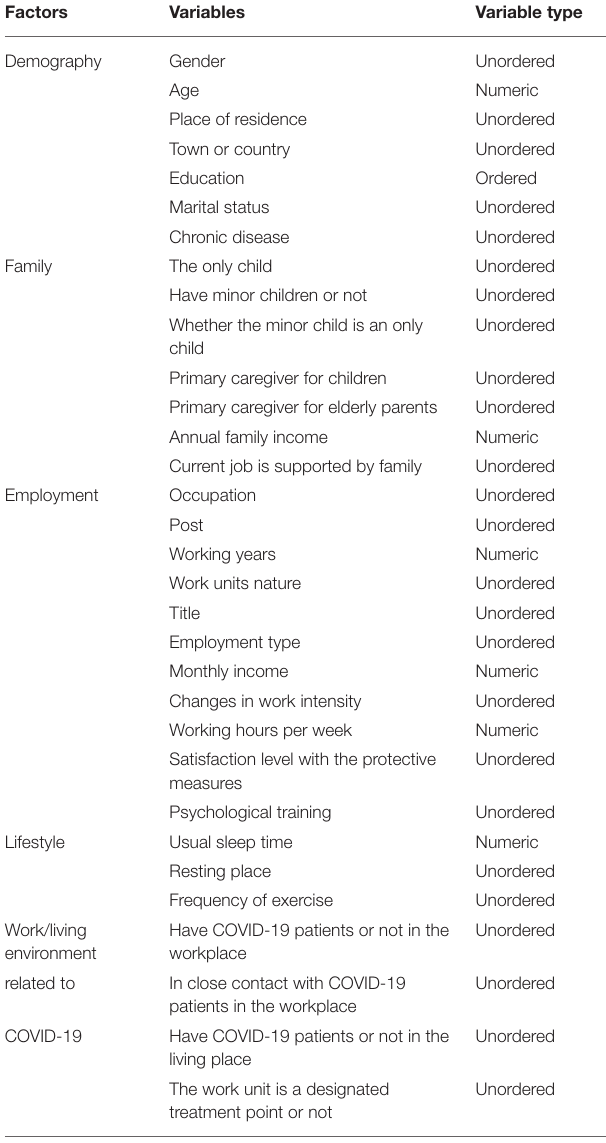
TABLE 1 | The description of